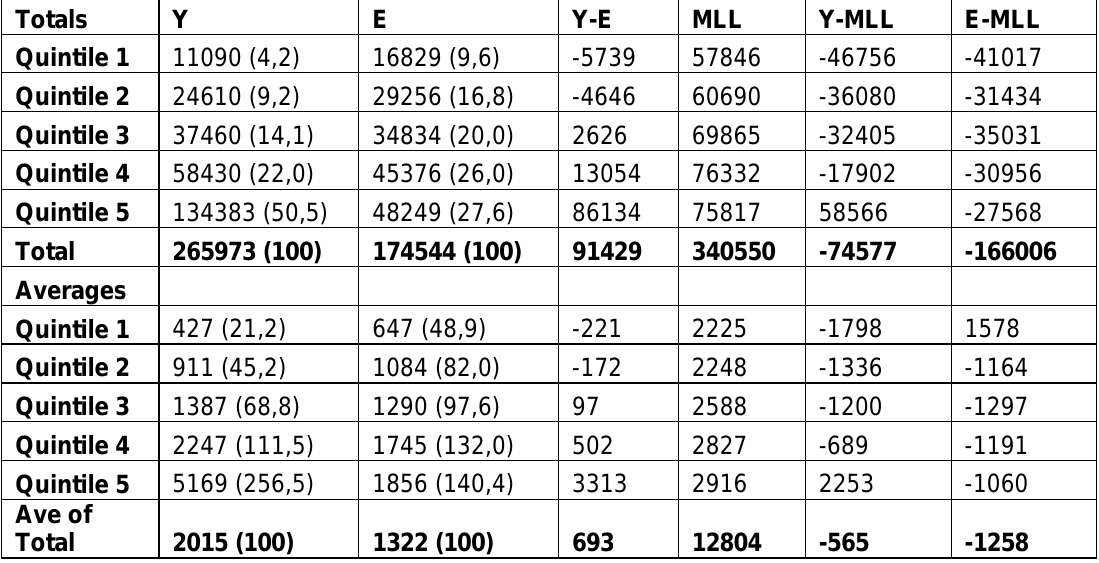
Table 3: Totals and averages of income, expenditure and MLL per household and